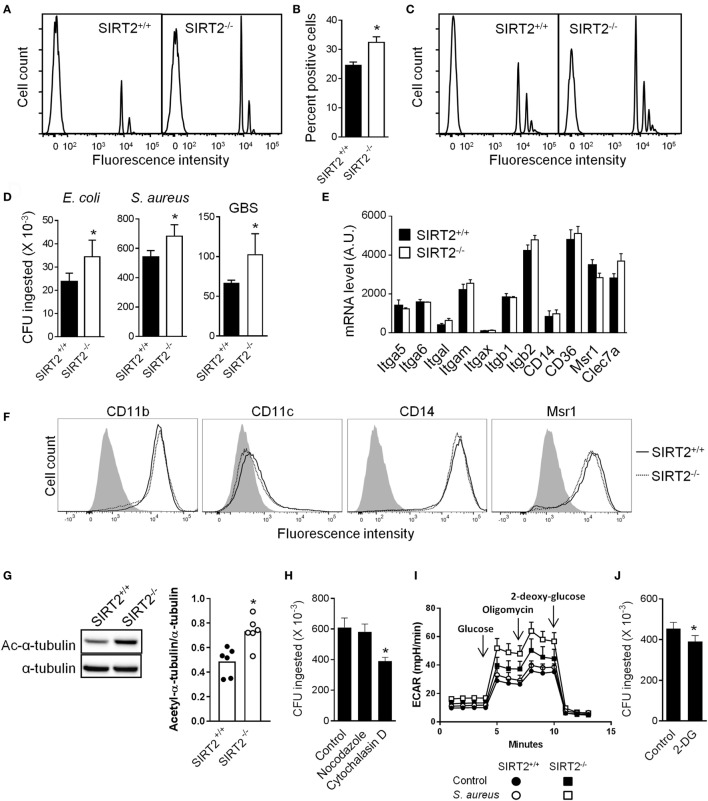
Sirtuin 2 (SIRT2) deficiency increases bacterial phagocytosis by macrophages. (A–C) SIRT2+/+ and SIRT2−/− BM-derived macrophages (BMDMs) were incubated with 10 fluorescent beads [opsonized in (C)] per cell. After 1 h, cells were analyzed by flow cytometry. Representative histograms are depicted in (A,C). The percentage of fluorescent cells was calculated (B). Data are means ± SD from an experiment performed with four mice (*P = 0.002). (D) SIRT2+/+ and SIRT2−/− BMDMs were incubated with live Escherchia coli, Staphylococcus aureus, and Group B Streptococcus (GBS) (10 bacteria/cell). Phagocytosis was assessed after 1 h. Data are means ± SD from one experiment performed with four (E. coli and GBS) or eight (S. aureus) mice. *P = 0.03, 0.006, and 0.03 for E. coli, S. aureus, and GBS, respectively. (E) Itga5, Itga6, Itgal, Itgam, Itgax, Itgb1, Itgb2, Cd14, Cd36, Msr1, and Clec7a mRNA expression levels in SIRT2+/+ and SIRT2−/− BMDMs. Data are means ± SD of one experiment performed with three mice. (F) CD11b, CD11c, CD14, and Msr1 expression levels were analyzed by flow cytometry. The gray histogram represents staining with an isotype control antibody. (G) Expression levels of acetylated (Ac) and total tubulin in BMDMs were analyzed by western blotting and quantified by imaging. Data are means ± SD from six mice (right panel) (*P = 0.015). Full-length blots are presented in Figure S2 in Supplementary Material. (H) Phagocytosis of S. aureus [performed as in (D)] by SIRT2−/− BMDMs preincubated for 1 h with or without nocodazole (10 µM) and cytochalasin D (10 µM). Data are means ± SD from one experiment performed with four mice (*P = 0.008). (I) Glycolytic capacity of BMDMs assessed by measuring the extracellular acidification rate (ECAR) using the Seahorse XF Glycolysis Stress Test Kit as described in Section “Materials and Methods.” Data are means ± SD from one experiment performed with three mice. (J) Phagocytosis of S. aureus [performed as in (D)] by SIRT2−/− BMDMs preincubated for 1 h with or without 25 mM 2-deoxy-glucose (2-DG). Data are means ± SD from one experiment performed with four mice (*P = 0.017).